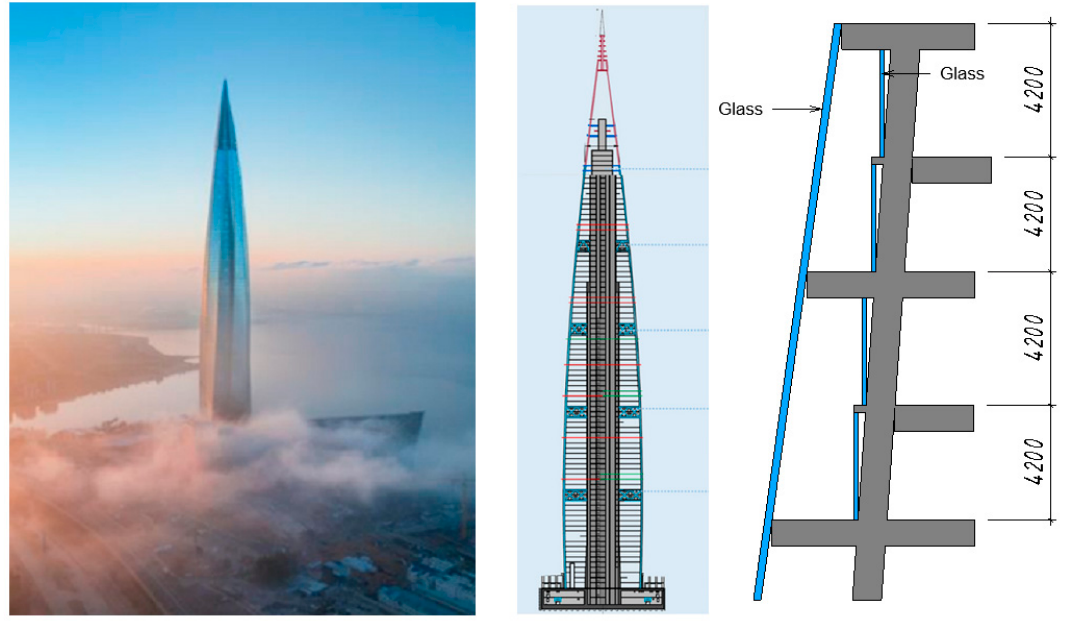
Figure 18 . Lakhta Center (data from ref. [145]) .